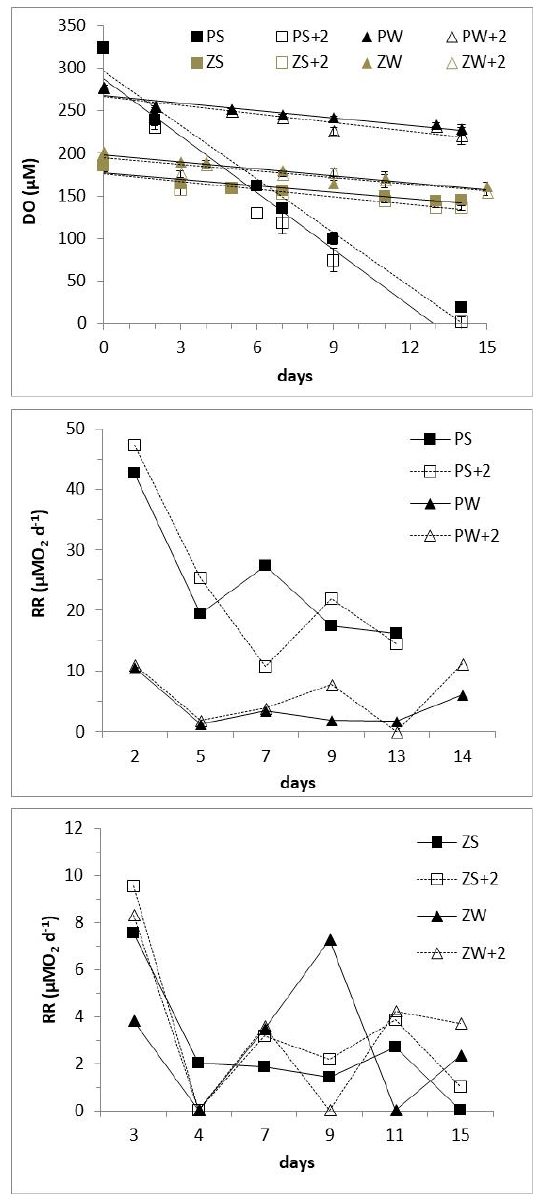
Figure 5. Top : changes in dissolved oxygen (DO) concentration with time. Slopes of regression lines (significance level p < 0.05) represent respiration rates (RR). Middle and bottom : changes in respiration rates (RR) with time. P: Pamvotis, Z: Ziros, S: summer, W: winter. Incubations at in situ temperature and at temperature increased by 2 °C (+2).